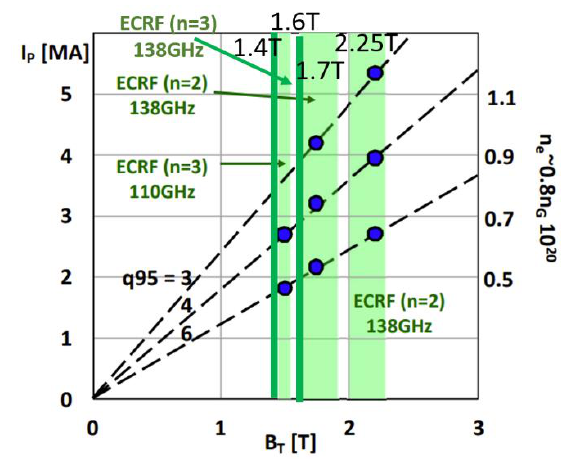
Fig. 1. Possible operational path for the rise to 5.5MA in the Initial Research phase. Adapted from